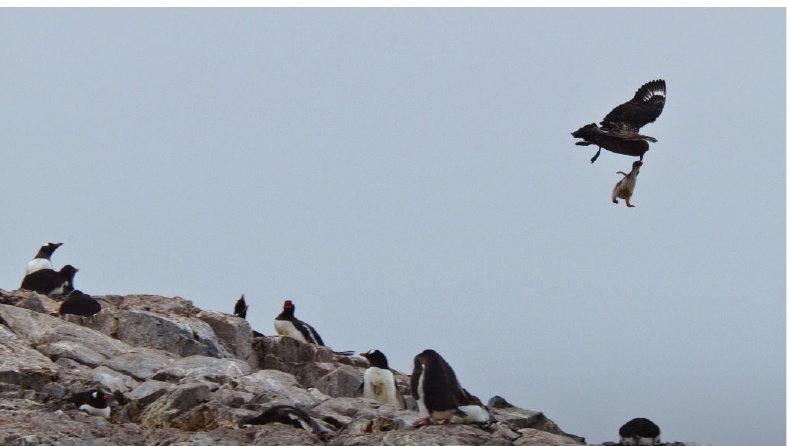
Figure 1. A brown skua Stercorarius antarcticus predates a gentoo penguin Pygoscelis papua chick on land. Cuverville Island, Antarctic Peninsula. Credit: PWH.